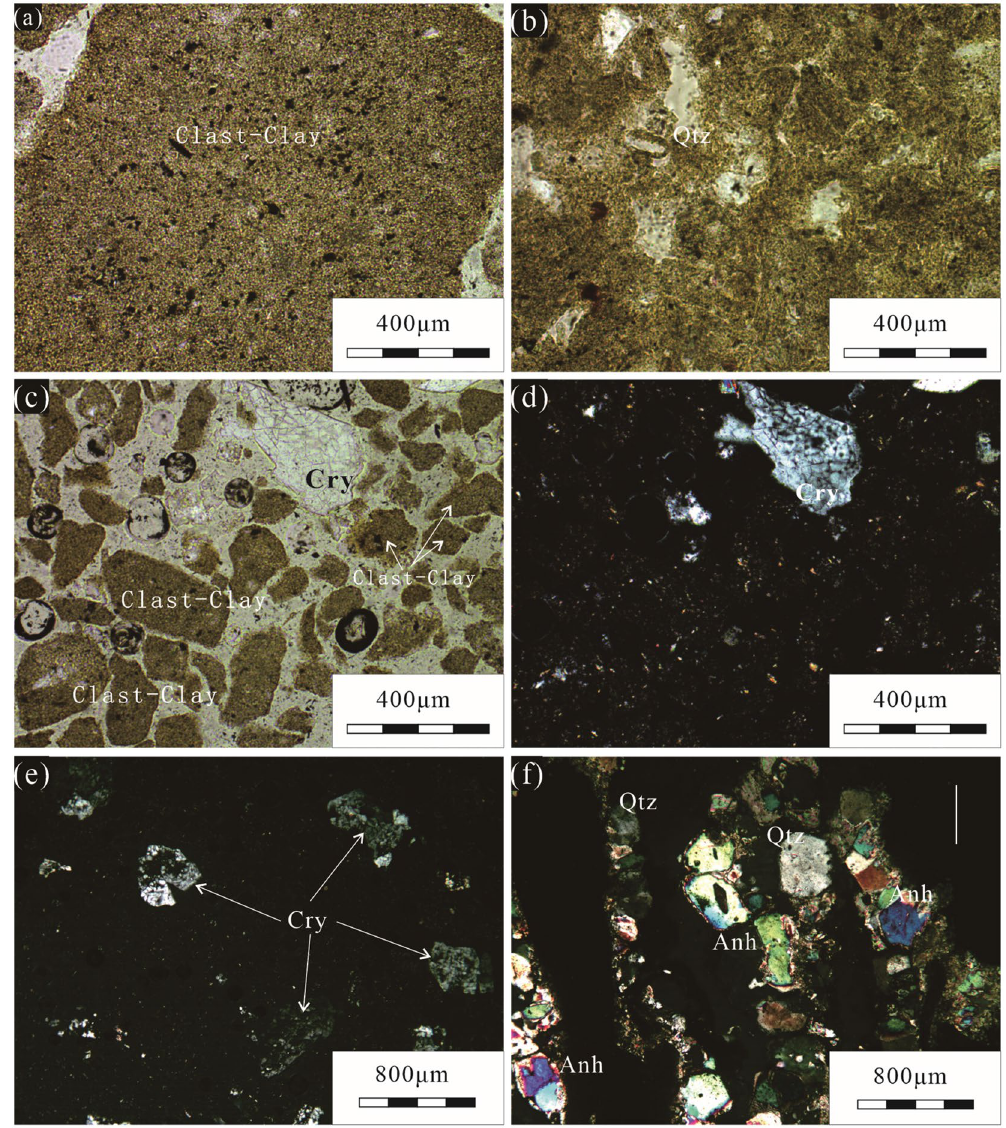
Figure 3. Photomicrographs showing typical characteristics of sample MK-3-T under polarized light; ( a ) very small grains, ( b ) monocrystalline α-quartz, ( c – e ) crystal fragment with irregular cracks, ( f ) crystals with larger- sized grains ( Cry crystal fragment, Qtz quartz, Anh